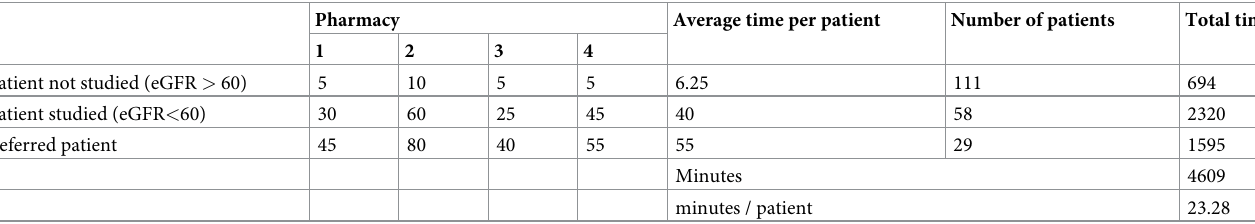
Table 11. Time, in minutes, dedicated by each pharmacy to patient